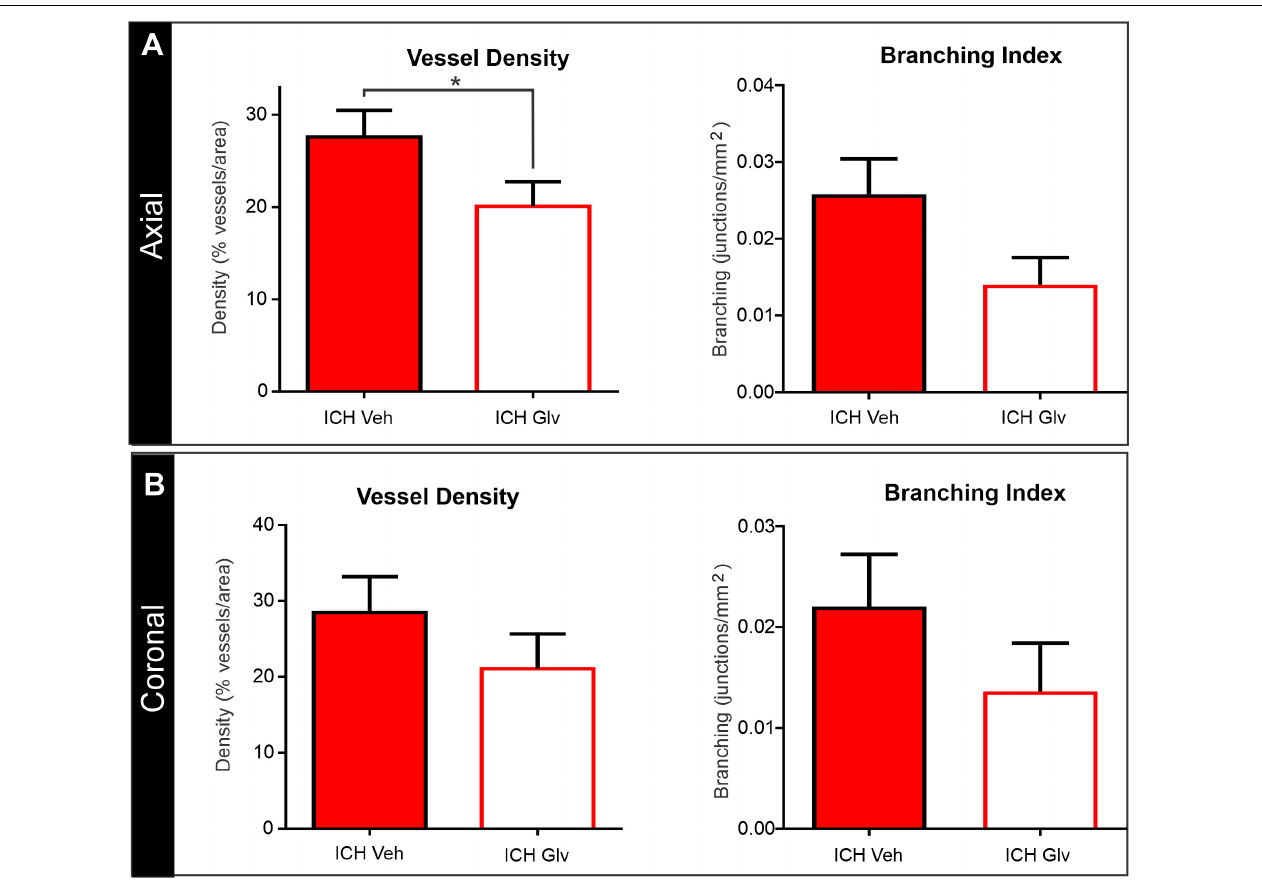
FIGURE 5 | Confocal vascular analysis also demonstrated that Gleevec treatment does not improve vascular density. (A) Quantitative assessment of axial cortical vascular features adjacent to the ICH injection site, revealed significant decrements in vascular density and trending decreases in vessel branching after Gleevec treatment. (B) Vascular features from cortical sections from coronal tissues also showed decreased vascular density and branching but did not reach significance. Note that both cortical assessments (axial vs. coronal) had similar relative decreases in vascular features (see Figure 4 for images) (* p <